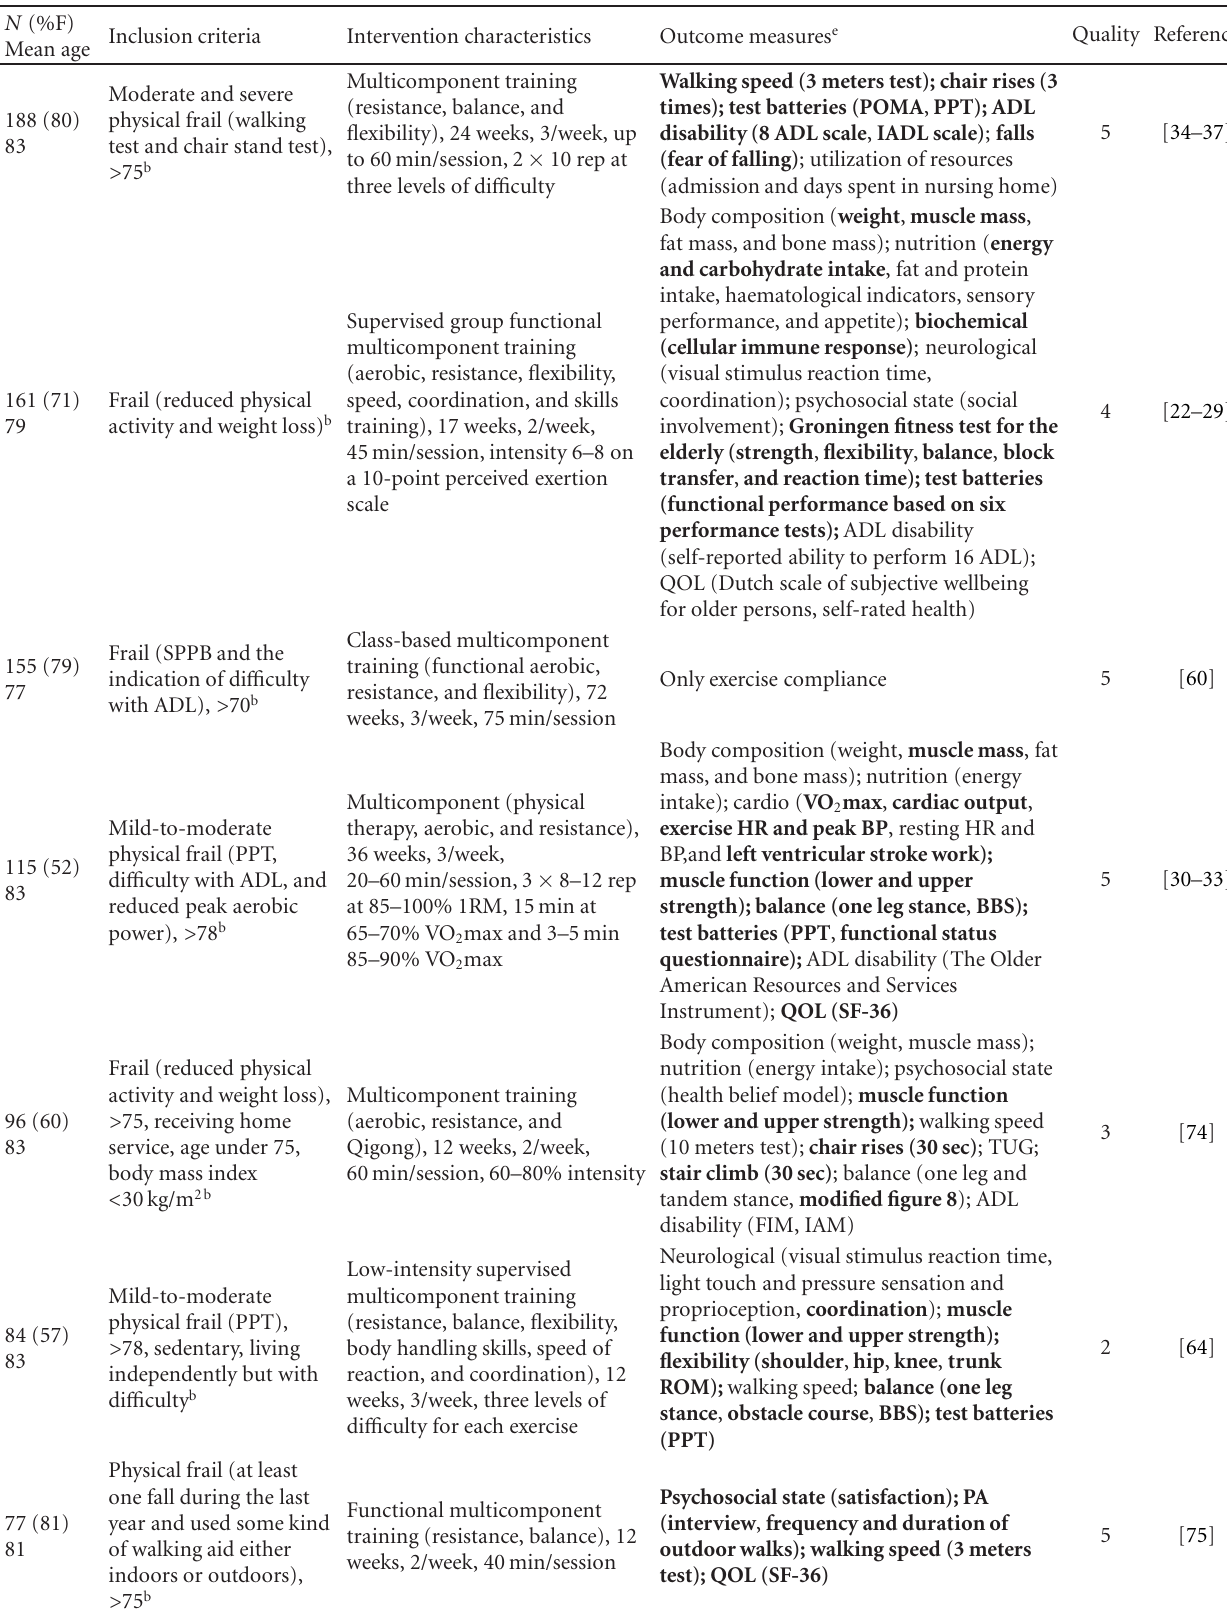
Table 2: Description of studies that included community-dwelling older